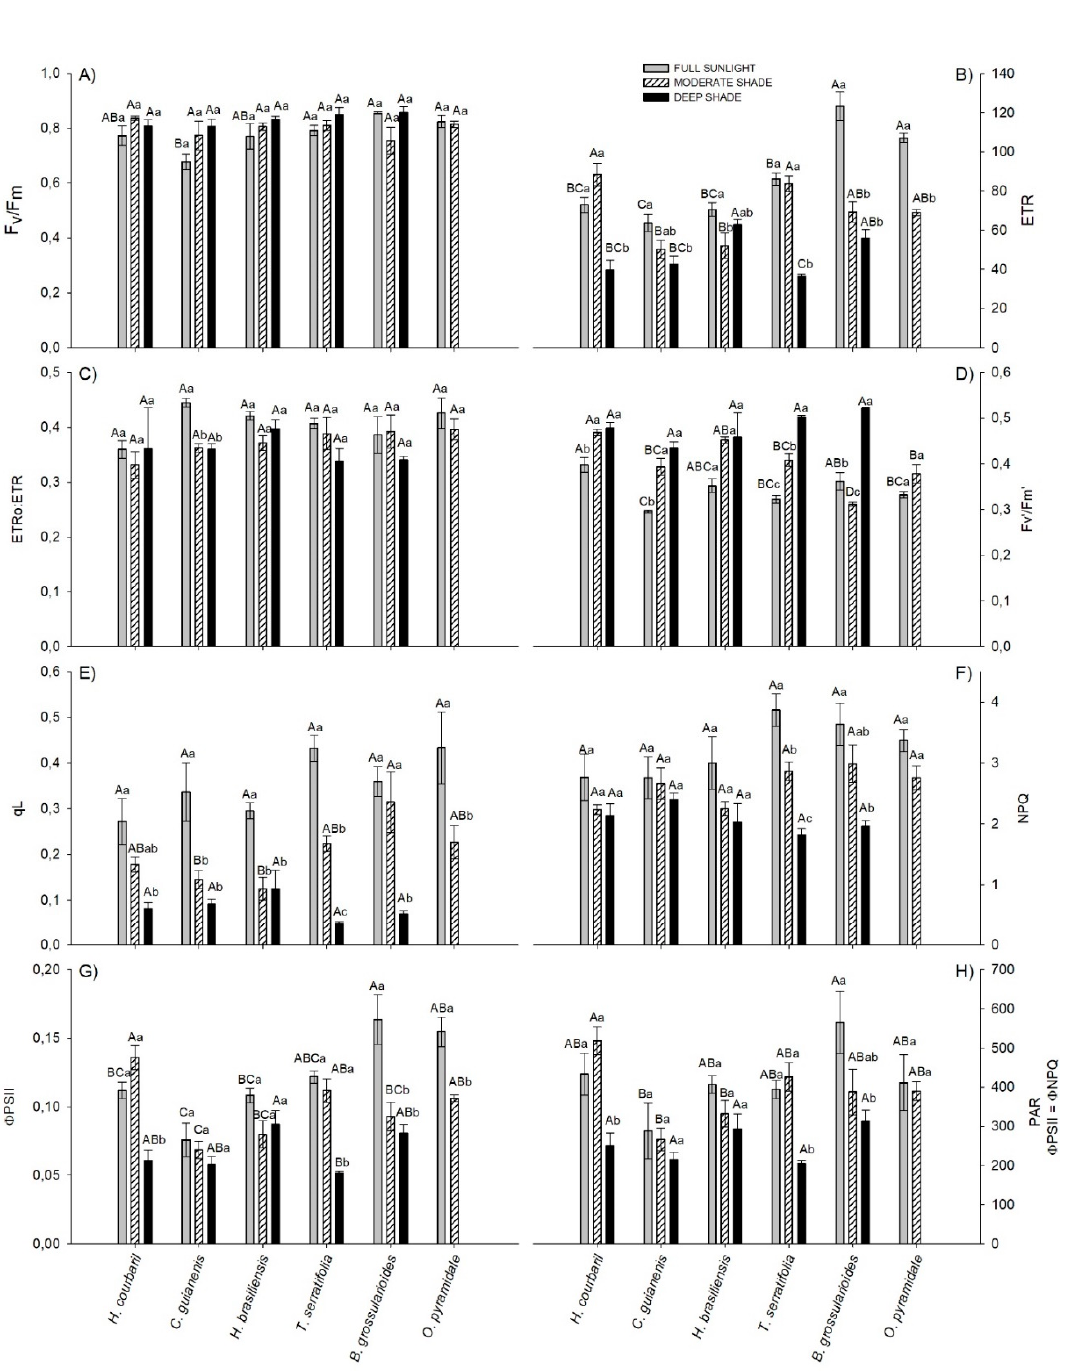
Figure 1. Fluorescence parameters at saturating light (PAR = 1500 µ mol m − 2 s − 1 ) of six tree species submitted to three di ff erent light environments: ( A ) Maximum quantum e ffi ciency of PSII, ( B ) Electrons transport rate, ( C ) Fraction of electrons destined for photorespiration, ( D ) Maximum e ffi ciency of PSII in the light, ( E ) Photochemical quenching, ( F ) Non-photochemical quenching, ( G ) E ff ective quantum e ffi ciency of PSII and ( H ) Irradiance wich which the non-photochemical quenching yield overcome the E ff ective quantum yield of PSII. Same capital letters for di ff erent species in same environment and small case for same species in di ff erent environment are equal by Tukey test ( p < 0.05). Vertical bars indicate the standard error ( n = 4).